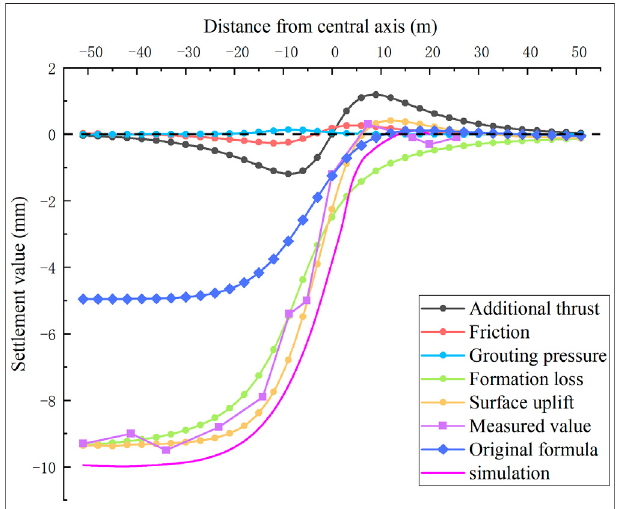
FIGURE 11 | Longitudinal surface deformation of Section 2 .